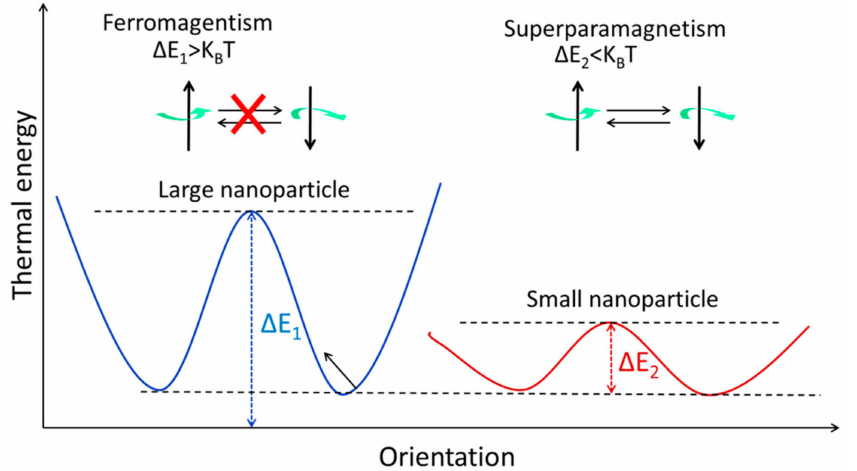
Figure 3. The energy levels of magnetic NPs with varying magnetic spin orientations. When it comes to stopping the magnetization from rotating, thermal energy (K B T) is the limiting factor. Both ferromagnetism and superparamagnetism may be seen in the large and small NPs,